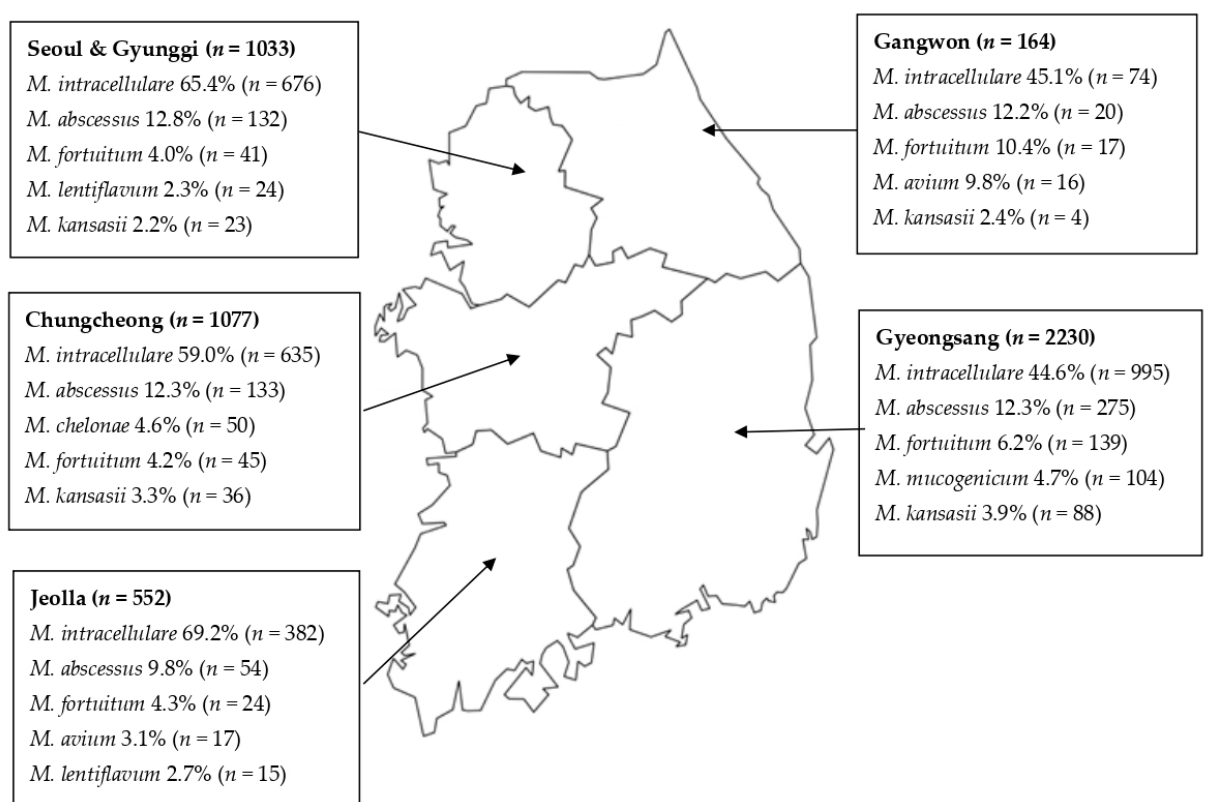
Figure 4. Regional distribution of nontuberculous mycobacteria species isolated from pulmonary sites in South Korea.